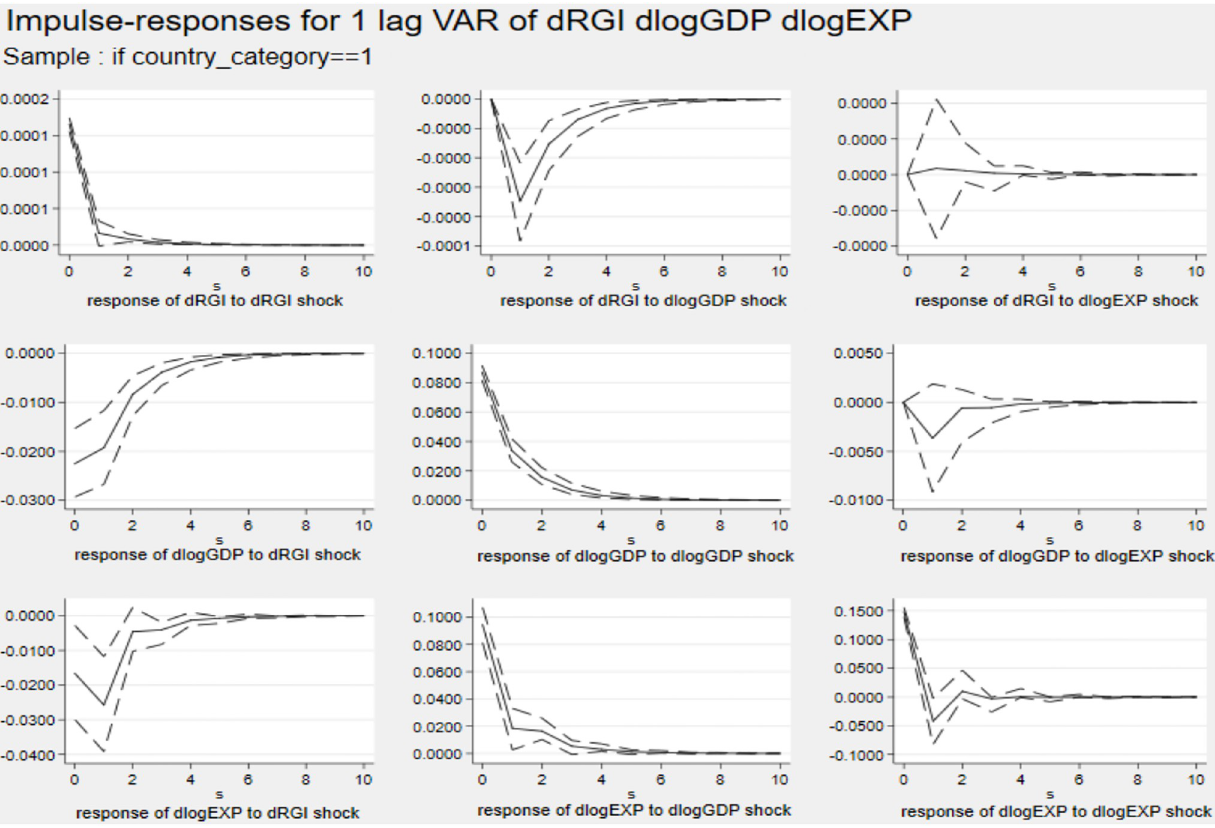
Fig 3. Impulse response diagram in Cluster 2. Notes : Errors are 5% on each side generated by Monte-Carlo with 2000 reps.